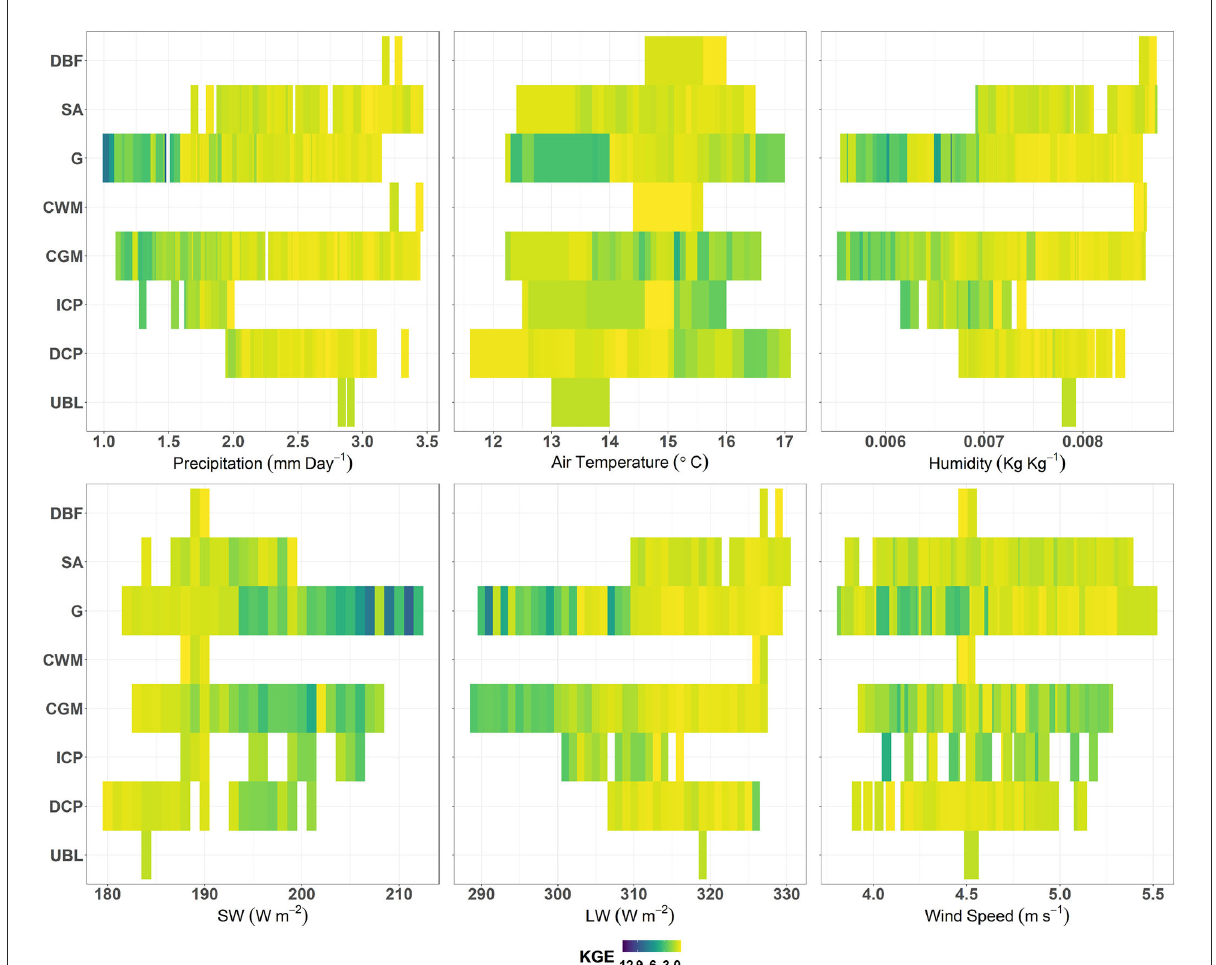
FIGURE14 The variation of the KGE between the model and MODIS LE flux with respect to the dominant land cover and the 11-year mean annual NLDAS-2 forcing components including precipitation, air temperature, specific humidity, downward shortwave (SW) and longwave (LW) radiation, and wind